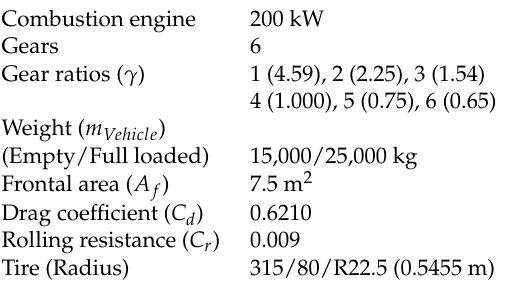
Table 2. RCV Characteristics.